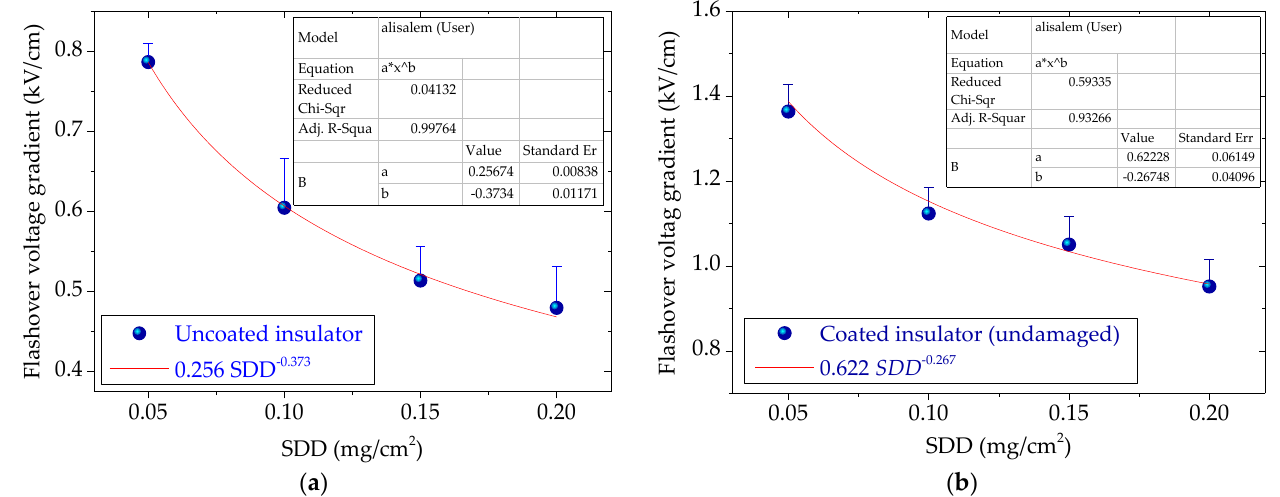
Figure 7. Flashover voltage gradient of polluted insulator: ( a ) without RTV coating; ( b ) with RTV coating.